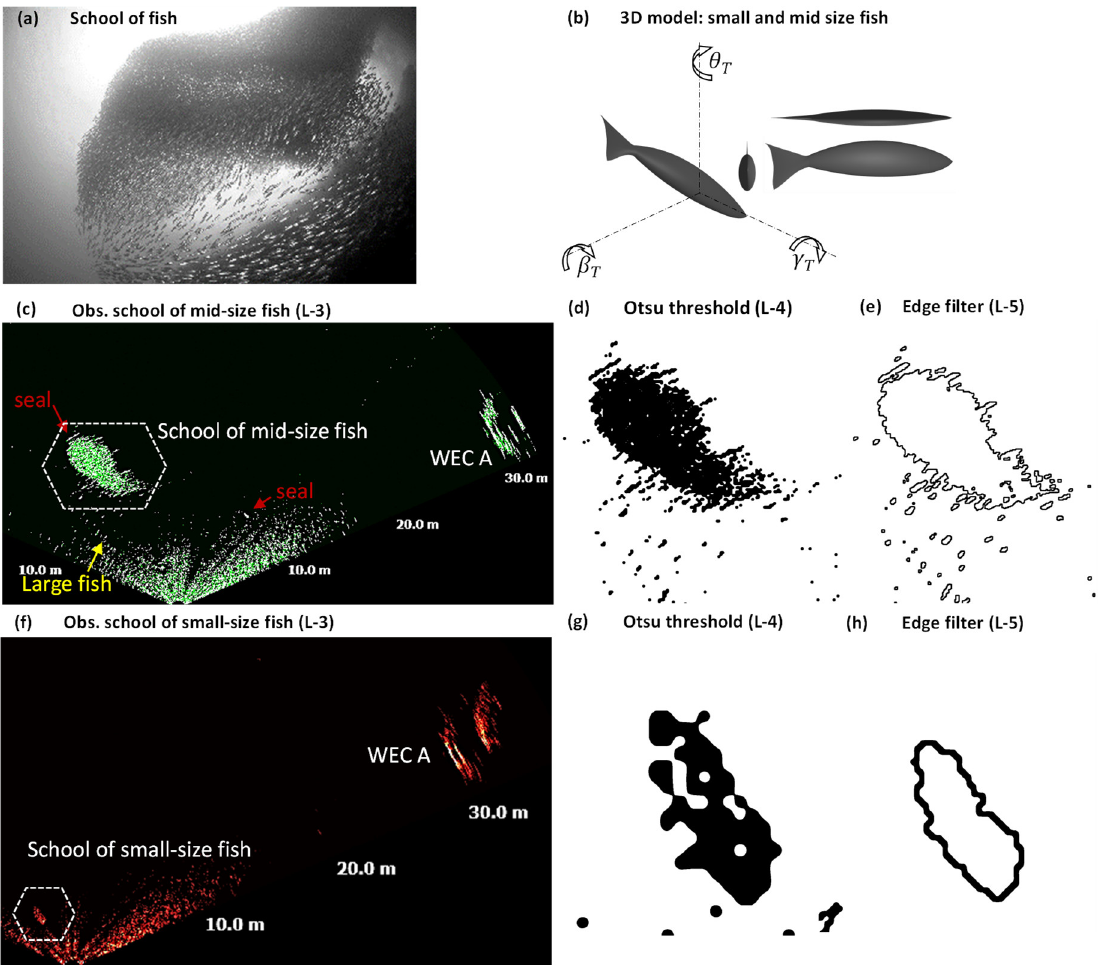
Figure 4. Visual signatures of schools of fish. ( a ) Assumed image of school of fish. ( b ) Computer rendering of a three dimensional (3D) model of small and mid-size fish, including the yaw ( θ T ), pitch ( β T ), roll ( γ T ) angles. ( c and f ) Acoustic images processed on ProViewer4 at level 3 (L-3) showing a school of mid-size fish with ( c ) school with 12 m of diameter at 10–17 m of range; and ( f ) small-size fish, school with 1.5 m of diameter at 3.5–6 m of range. Shapes and silhouettes of schools of fish processed on FIJI with ( d and g ) Otsu threshold; ( e ) Edge filter; ( h ) outline filter.